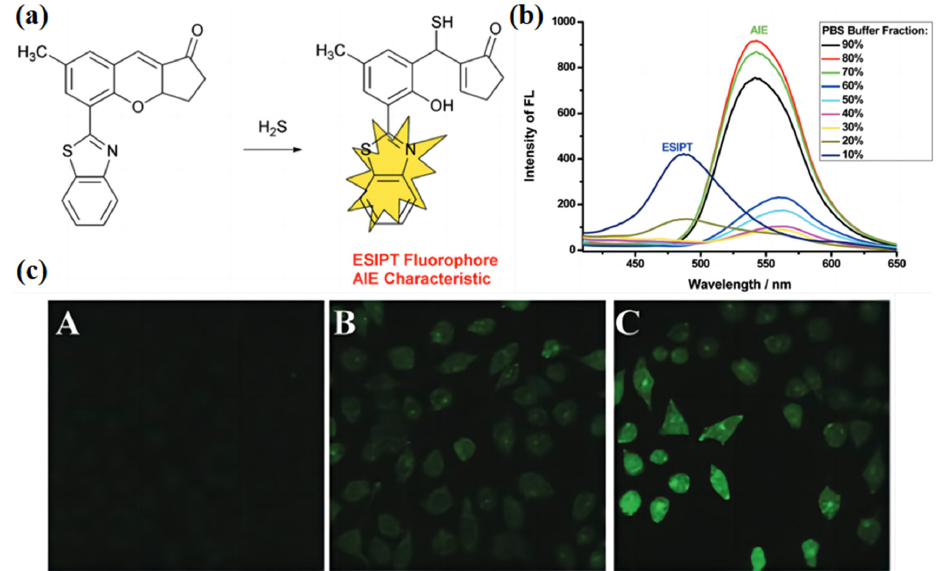
Figure 7. ( a ) Molecular structure of probe 1 and the proposed sensing mechanism for H 2 S. ( b ) Fluorescence spectra of probe 1 upon the addition of H 2 S (3 equivalents) in DMF with different vol% fractions of PBS buffer. Adapted with permission from [77]. ( c ) HeLa cells were incubated with 10 µ M of probe 1 for 30 min, washed with DPBS, and incubated with (A) 0, (B) 10, and (C) 20 μ M of H 2 S for 30 min each. Adapted with permission from [77].